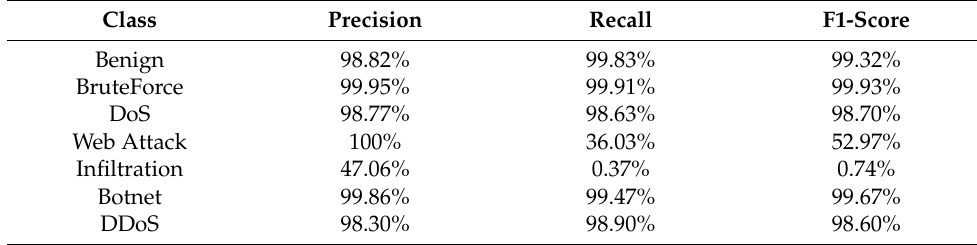
Table 23. RNN evaluation results for multi-class classification.